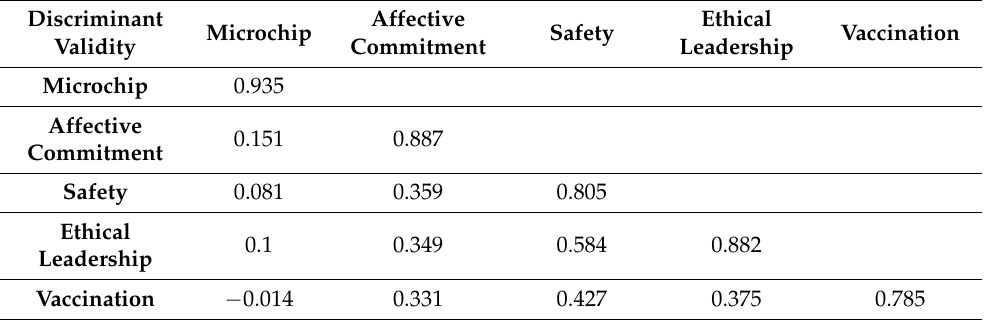
Table 3. Discriminant Validity Measures.